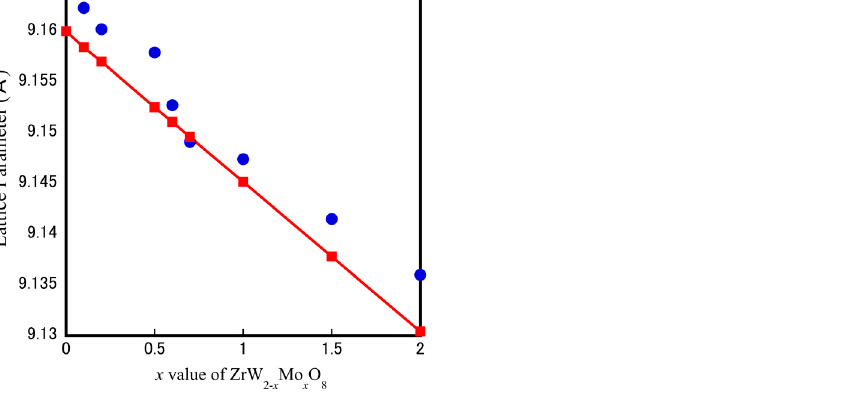
Figure 9. The trend of the lattice parameters of cubic-ZrW 2 − x Mo x O 8 (the blue circle marks represent the calculated value of lattice parameters, and red diamond marks represent the theoretical value based on the Vegard’s law).